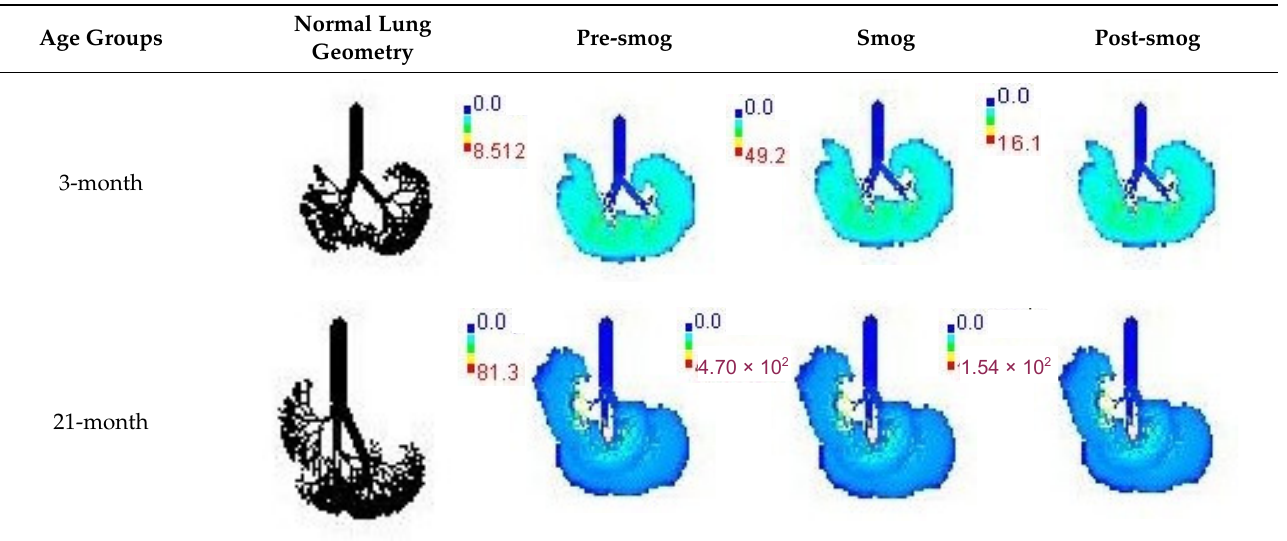
Table 7. Mass flux maps (µg/min/m 2 ) for different age groups during pre-, during, and post-Smog-2017.